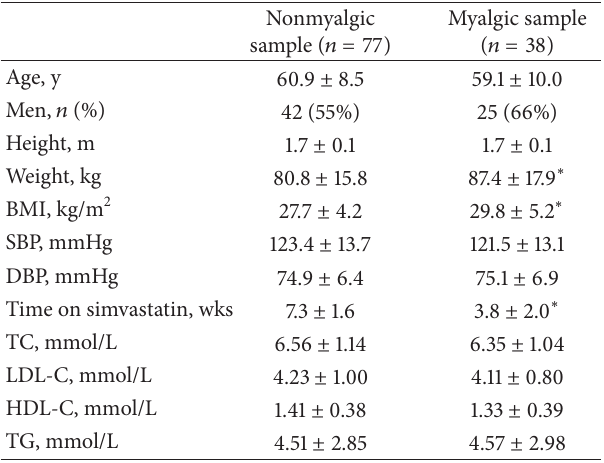
Table1:Baselinecharacteristicsofparticipantsbymyalgiastatus a,b,c